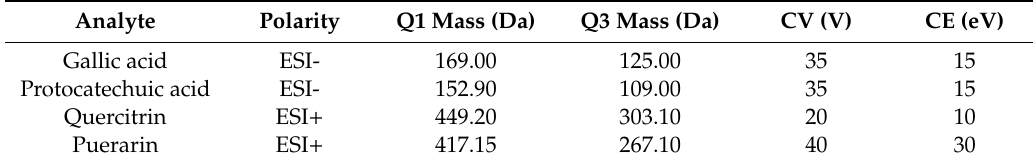
Table 5. List of selected MRM parameters, cone voltage (CV), collision energy (CE), and retention time of each analyte and internal standard